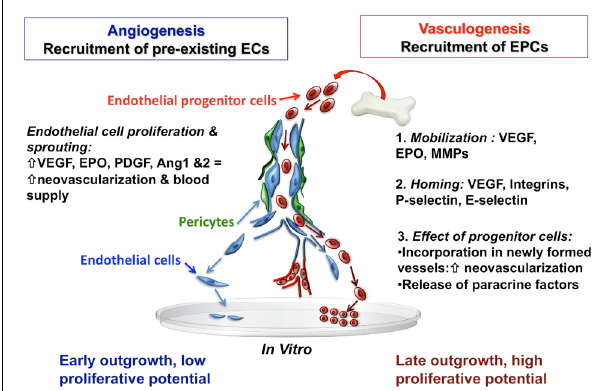
FIGURE 2 | Recruitment of endothelial cells from pre-existing vessel wall plays a critical role in the regulation of postnatal angiogenesis and vasculogenesis. Mobilized bone marrow or umbilical cord blood-derived EPCs with high proliferative capacity may have the potential to migrate and incorporate into the injured tissue vascular bed. Abbreviations: EC, endothelial cells; EPCs, endothelial progenitor cells; VEGF, vascular endothelial growth factor; EPO, erythropoietin; MMPs, matrix metalloproteinases, PDGF, platelet derived growth factor; Ang 1and2, angiopoietin 1 and